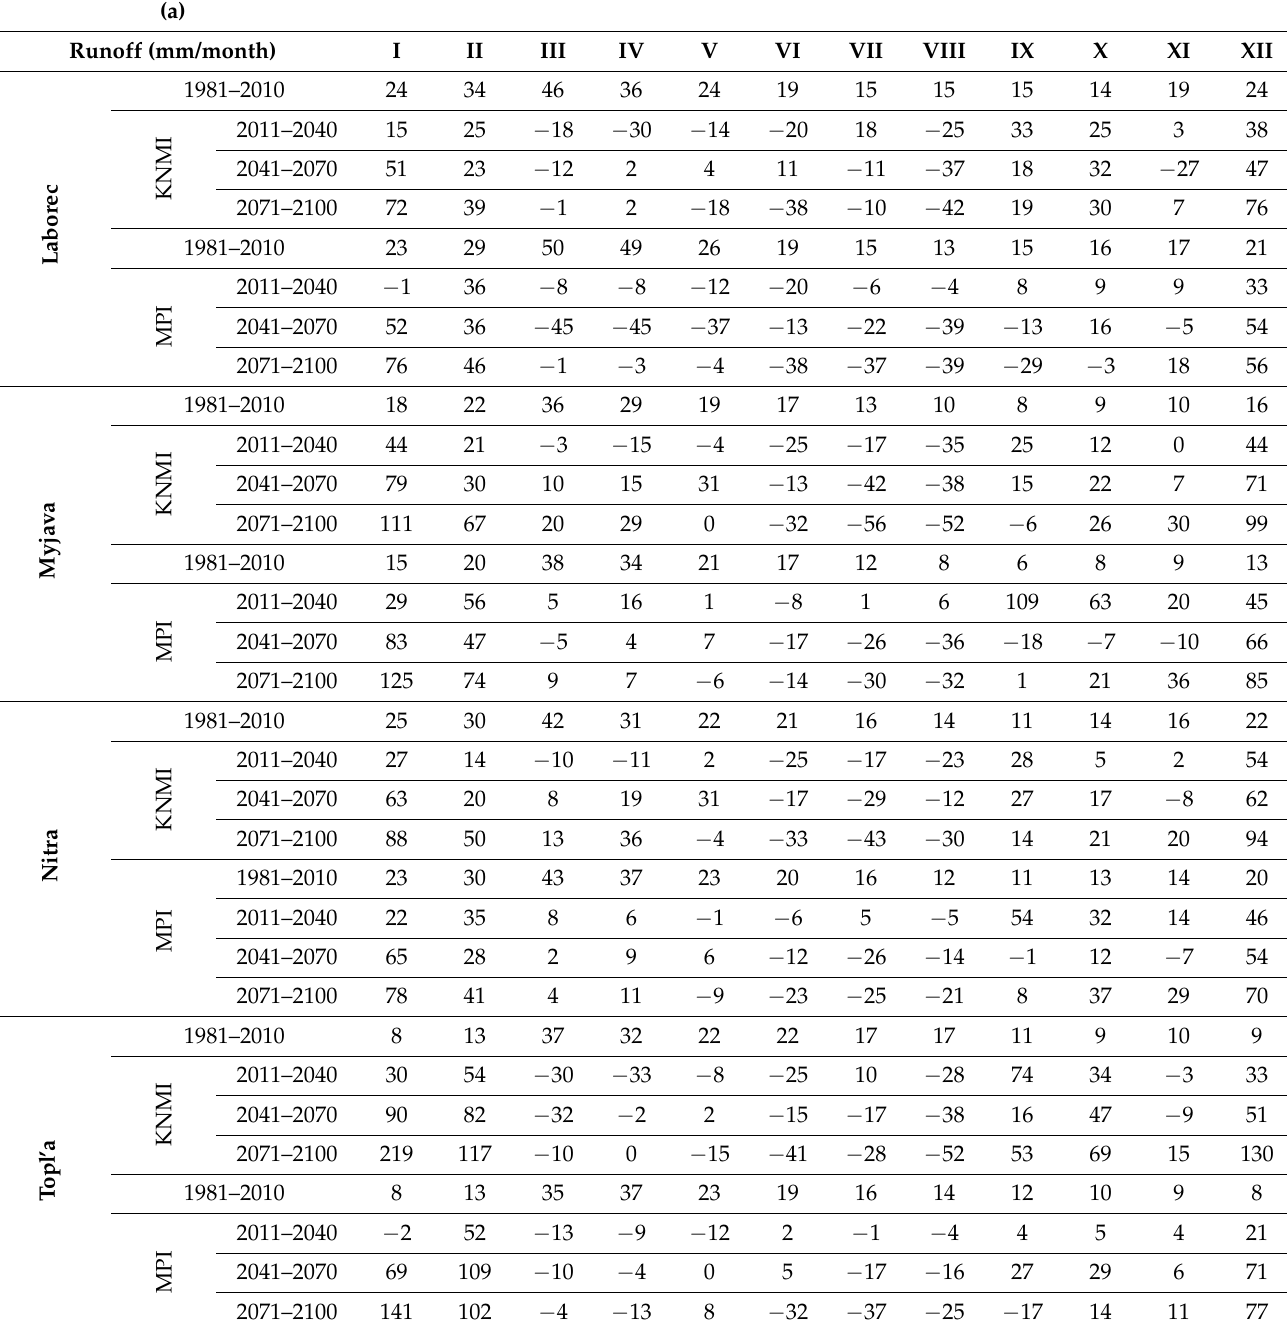
Table 6. Simulated long-term mean monthly runoff (mm/month) and its changes (%) for the three future time horizons: (a) in the river basins with a mean elevation < 435 m a.s.l.; (b) in the river basins with a mean elevation > 435 m